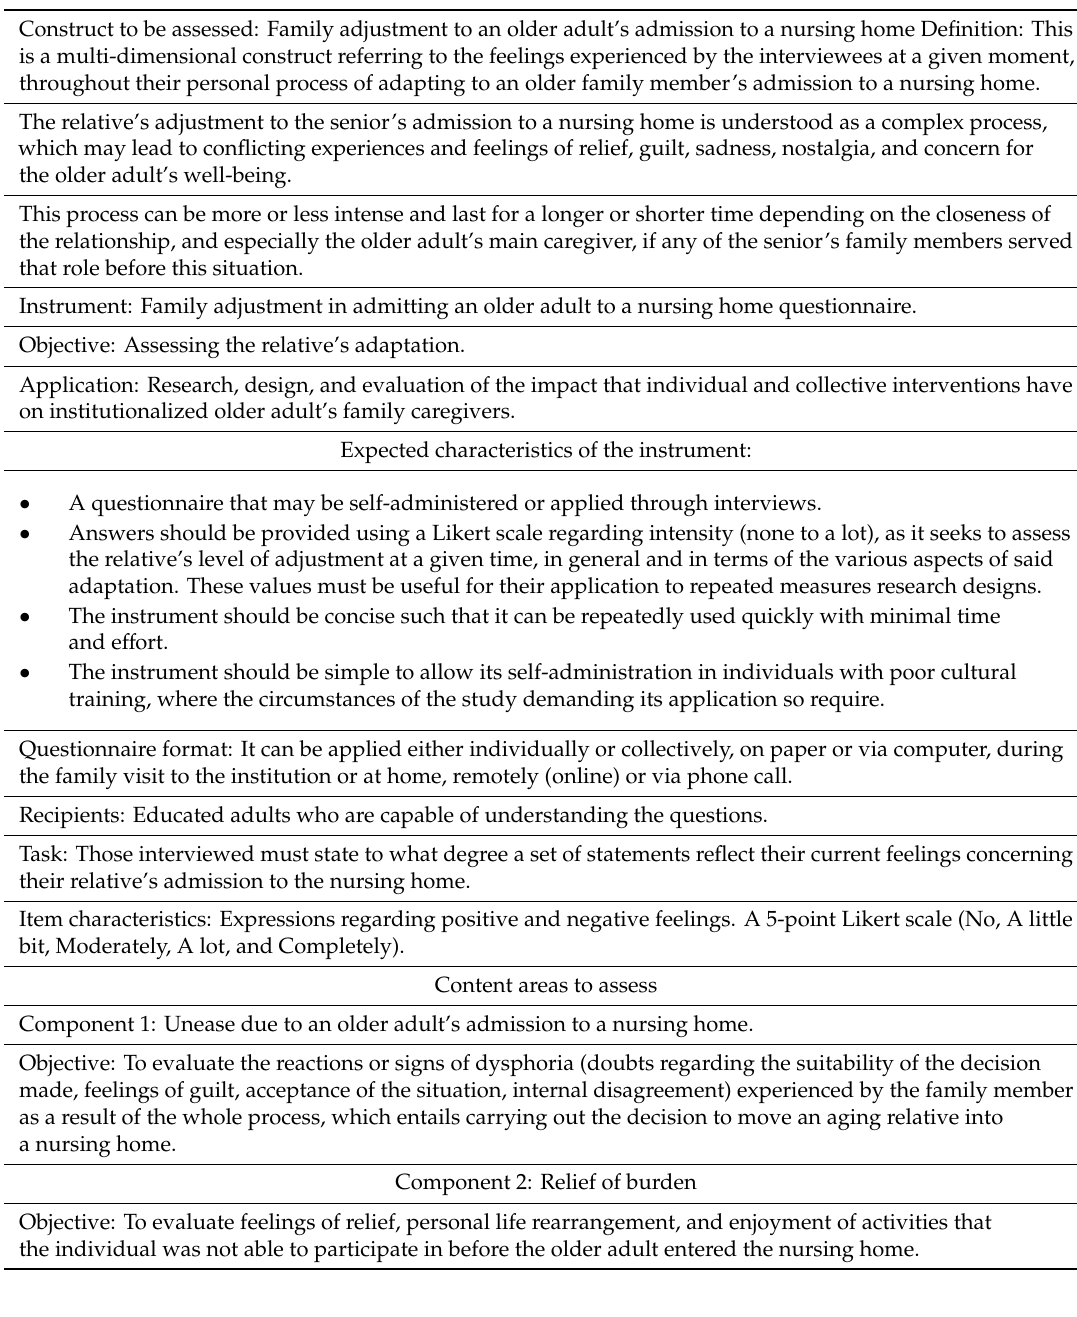
Table 2. Test and item